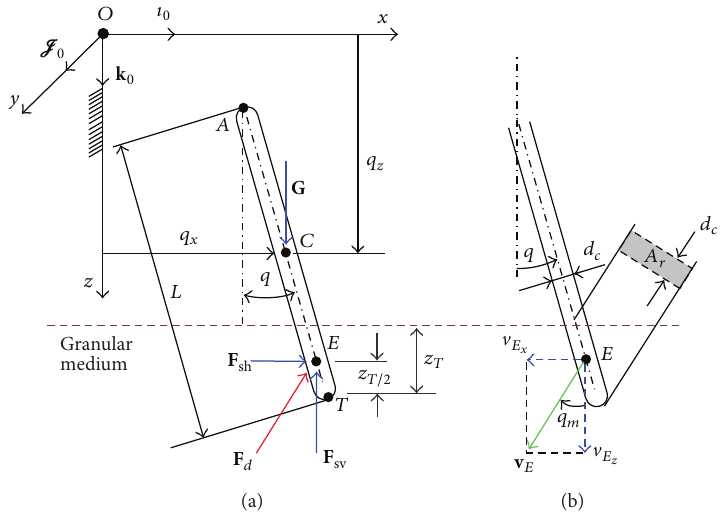
Figure 3: Free link: (a) generalized coordinates and free-body diagram; (b) reference area 𝐴 𝑟 and moving angle 𝑞 𝑚 .